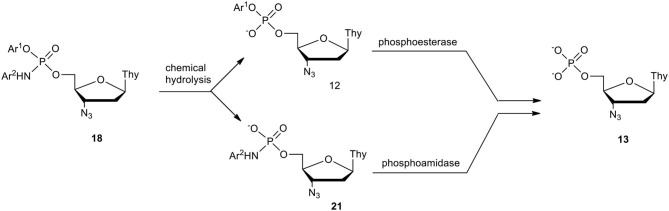
Plausible pathways of decomposition of aryl nucleoside (N-aryl)phosphoramidate 18 in RPMI/FCS on the example of AZT derivatives.